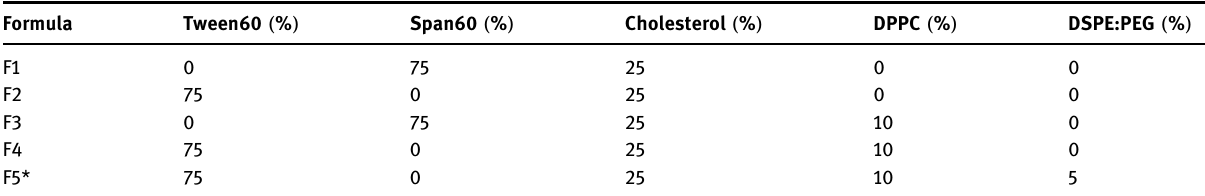
Table 2: Type of surfactant, di ff erent molar ratios of non - ionic surfactant l/cholesterol, and type of lipids used in synthesizing di ff erent Nio - HHE